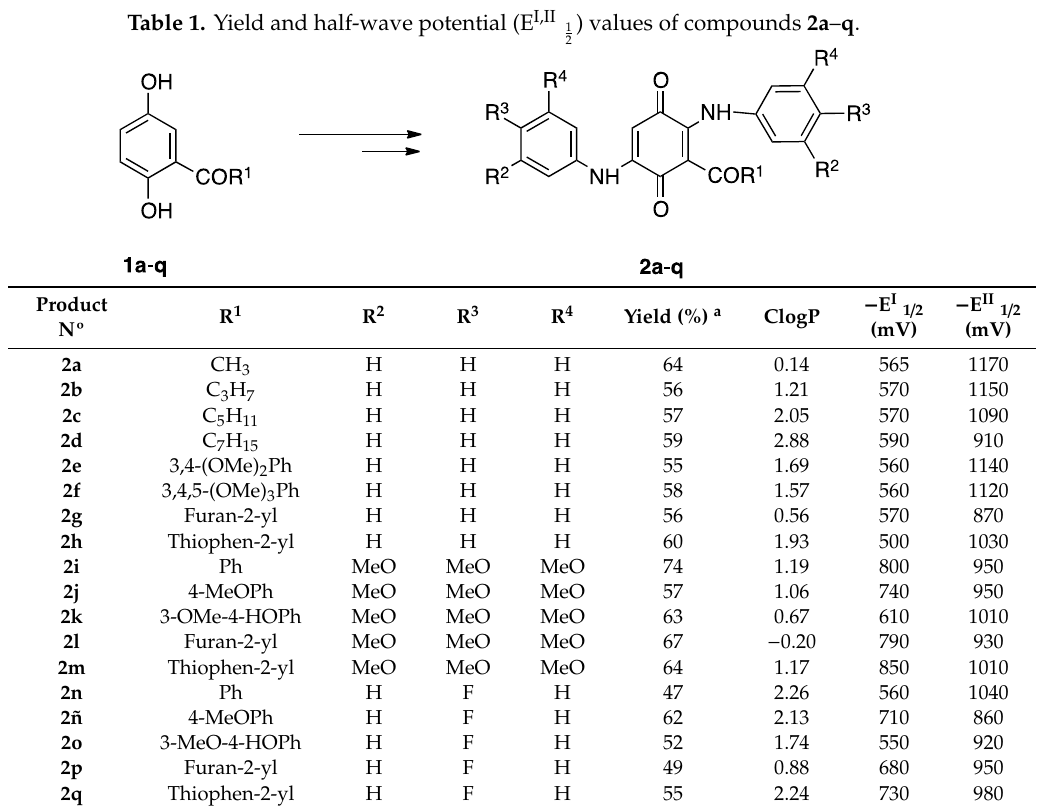
) values of compounds 2a – q . 2